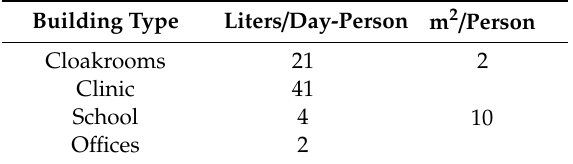
Table A6. Daily hot-water consumption and occupation density.